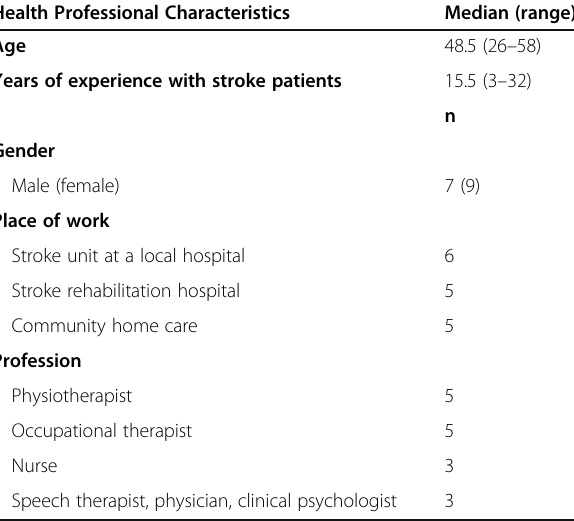
Table 3 Background characteristics of health professionals (focus group